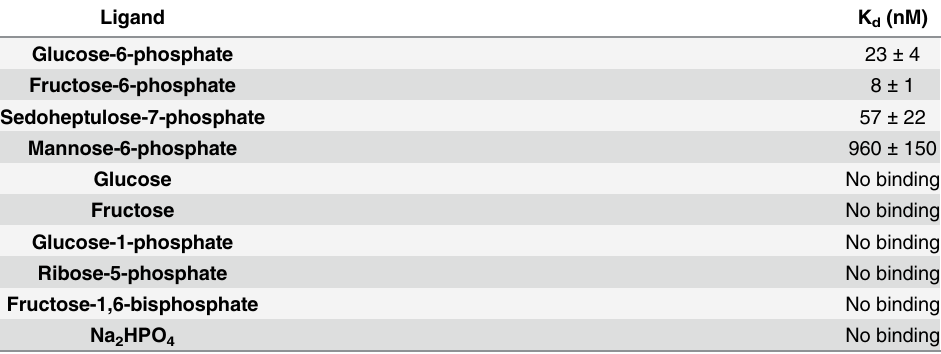
Table 2. Binding constants between WT A . pleuropneumoniae AfuA and screened molecules. Ligand K d (nM) Glucose-6-phosphate